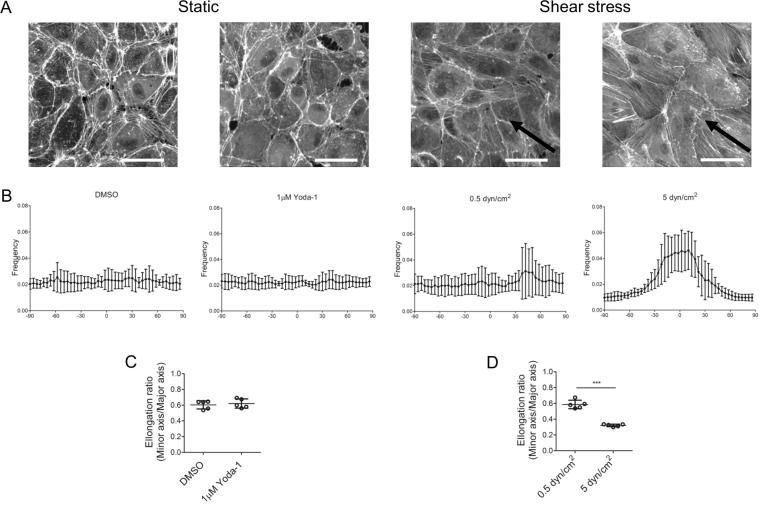
Yoda-1 treatment does not induce f-actin alignment and cell elongation. HUVEC were treated under static conditions for 24 h (1 μM Yoda-1 or DMSO), or under shear stress continuously (5 dyn/cm2) or a non-continuous low shear stress (0.5 dyn/cm2; 1 min flow cycle per 2 h). To visualise f-actin, cells were stained with phalloidin. (A) Representative confocal pictures for each condition. Arrow indicates the direction of media flow across the endothelium. Scale bar = 25 μm. (B) Directionality of f-actin fibres (relative to the direction of media flow when indicated by a black arrow) For each condition, three randomly selected fields of view were chosen for analysis. Data represent five independent repeats. (C–D) Elongation ratio (cell minor axis length)/ (cell major axis length). Non-paired students t-test conducted for the respective static and shear stress conditions ***P < 0.0001.